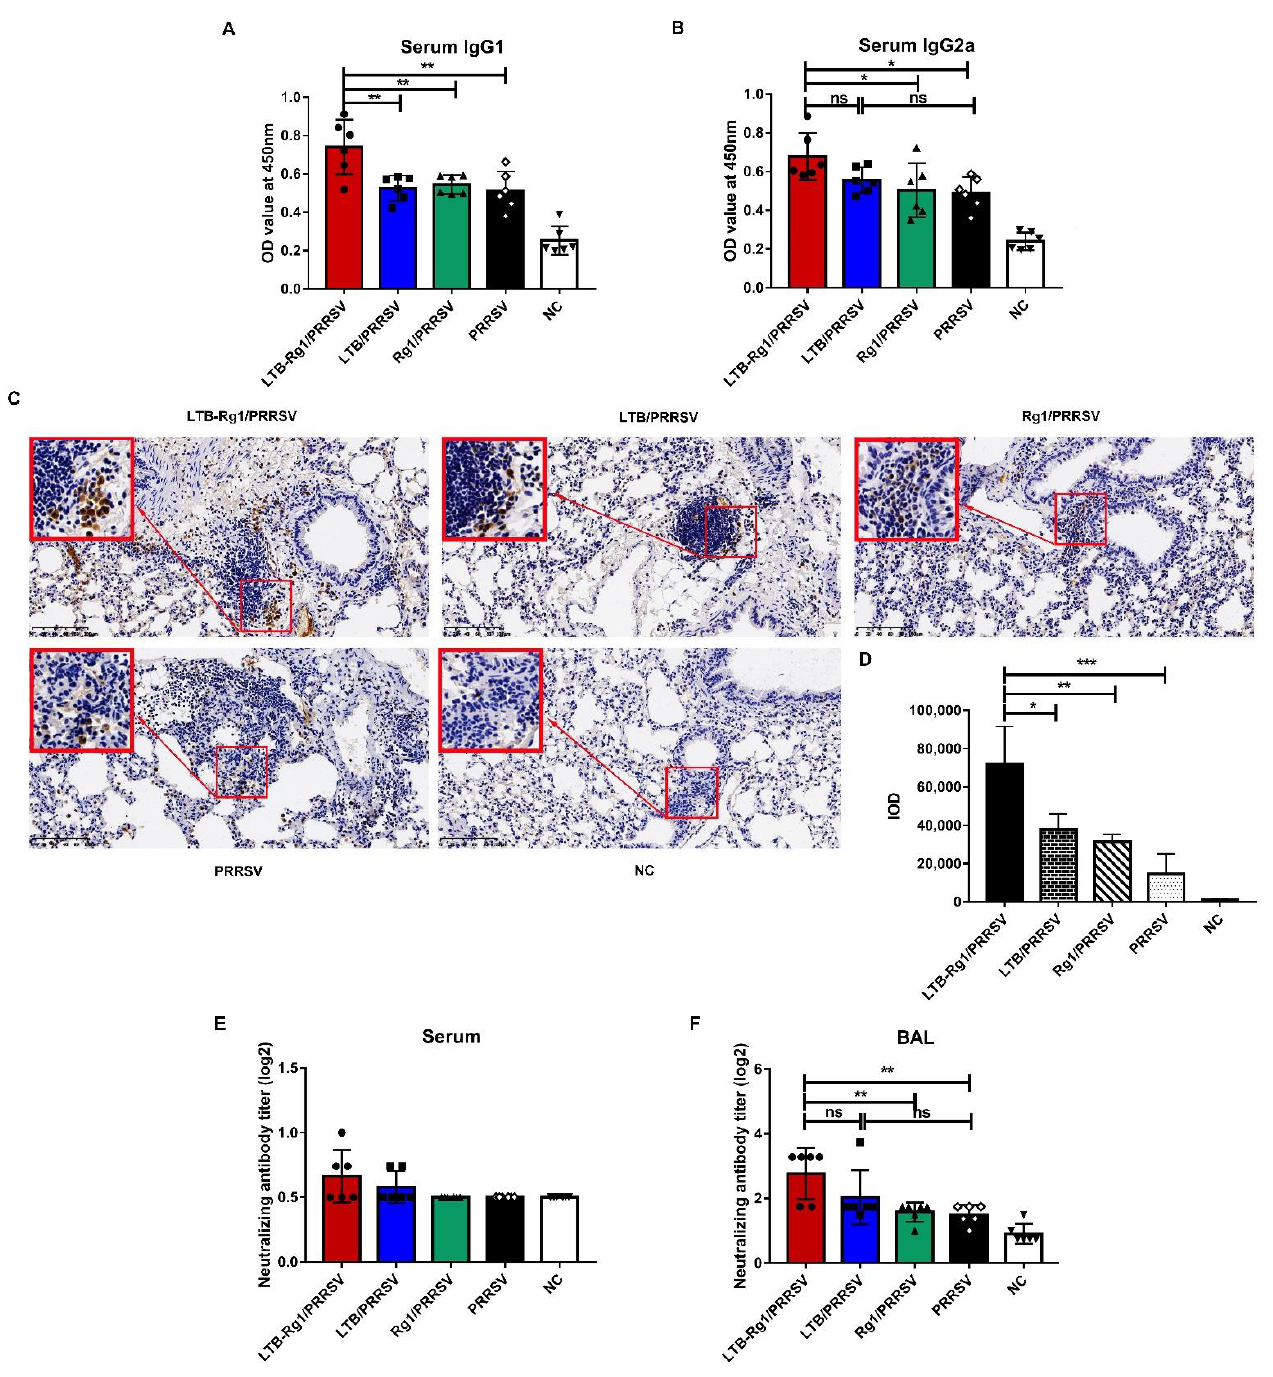
Figure 4. LTB-Rg1 significantly increased IgG isotypes, IgA-secreting plasma cells, and neutralizing antibody titers. Mice ( n = 6/group) were immunized intranasally with PRRSV vaccine admixed with saline, LTB, Rg1, or LTB-Rg1 and euthanized on day 35 post-priming. Non-immunized mice served as negative controls. ( A , B ) Sera were collected for determination of IgG1 and IgG2a responses. ( C ) Lung tissues were harvested for detection of IgA-secreting cells by immunohistochemical staining. ( D ) The integrated optical density (IOD) was analyzed. ( E , F ) Serum samples and BAL fluid were tested for neutralizing antibody titer. Data are expressed as means ± SD. * p < 0.05, ** p < 0.01, *** p < 0.001. ns, no significant difference.